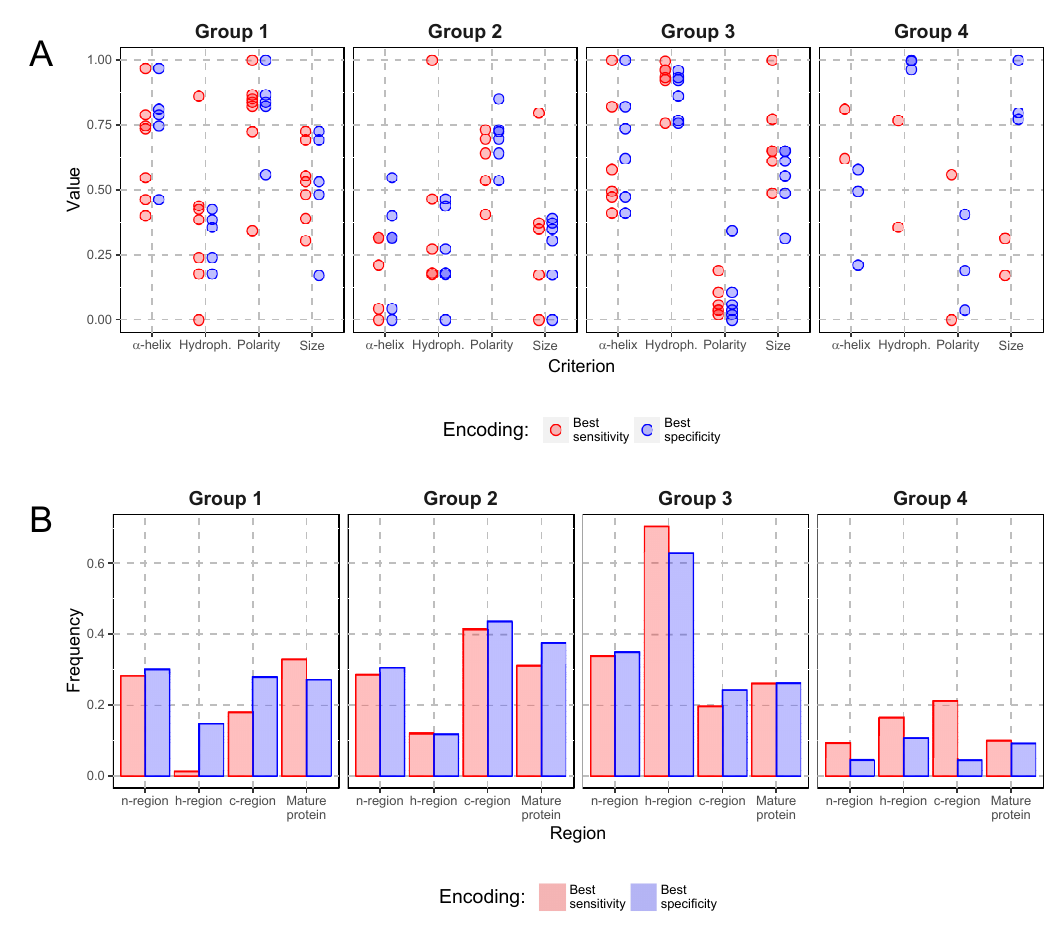
Figure 4. Comparison of amino acids classified into four groups providing the best sensitivity and specificity in the SP recognition. Normalized value of properties for particular amino acids represented by points ( A ). Frequencies of amino acids from the four groups in different regions of signal peptide and mature proteins ( B